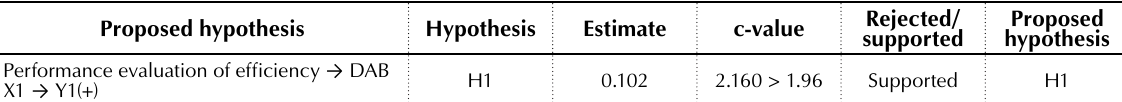
Table 1. Path coefficient of performance evaluation of efficiency focus and DAB Proposed hypothesis